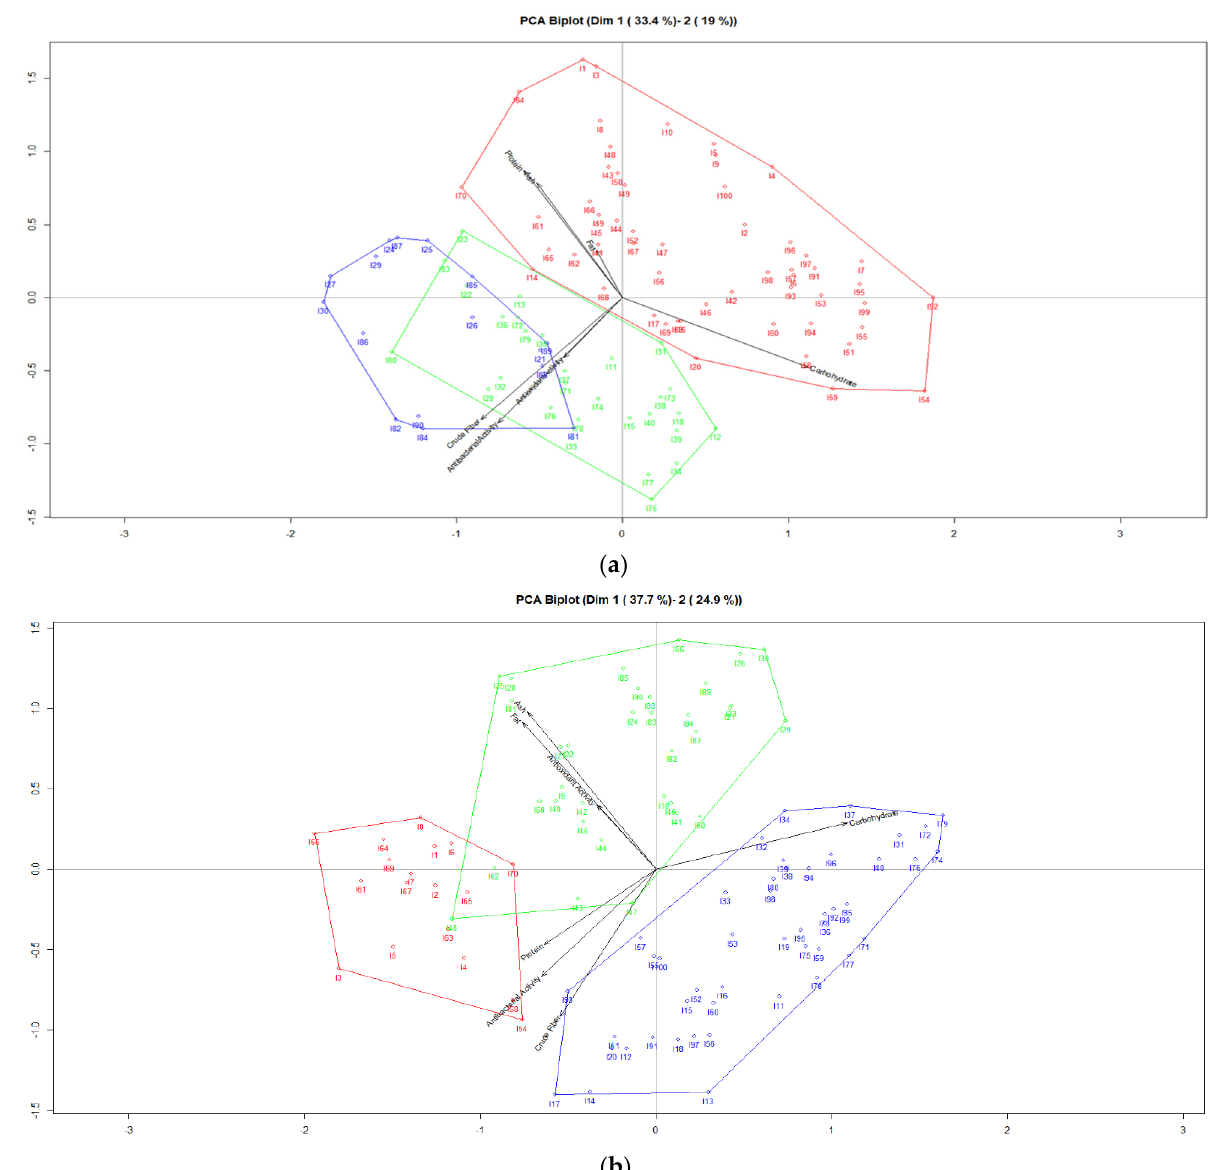
Figure 3. ( a ) K − means using 3 clusters for biological properties of Pleurotus ostreatus cultivated on two mixtures of agri- cultural wastes, ( b ) K − means using 3 clusters for biological properties of Pleurotus djamor cultivated on two mixtures of agricultural wastes.